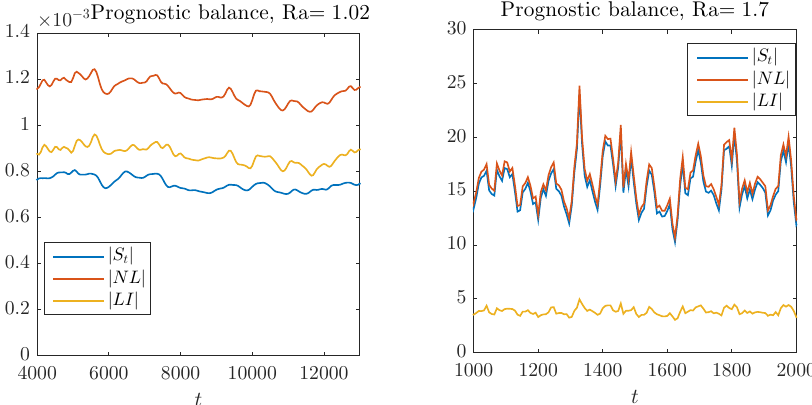
Figure 10. Balances in the prognostic equation in the statistically steady state when ( a ) Ra = 1.02 and ( b ) 1.7. The quantities S t , NL and LI are measured in terms of their r.m.s.